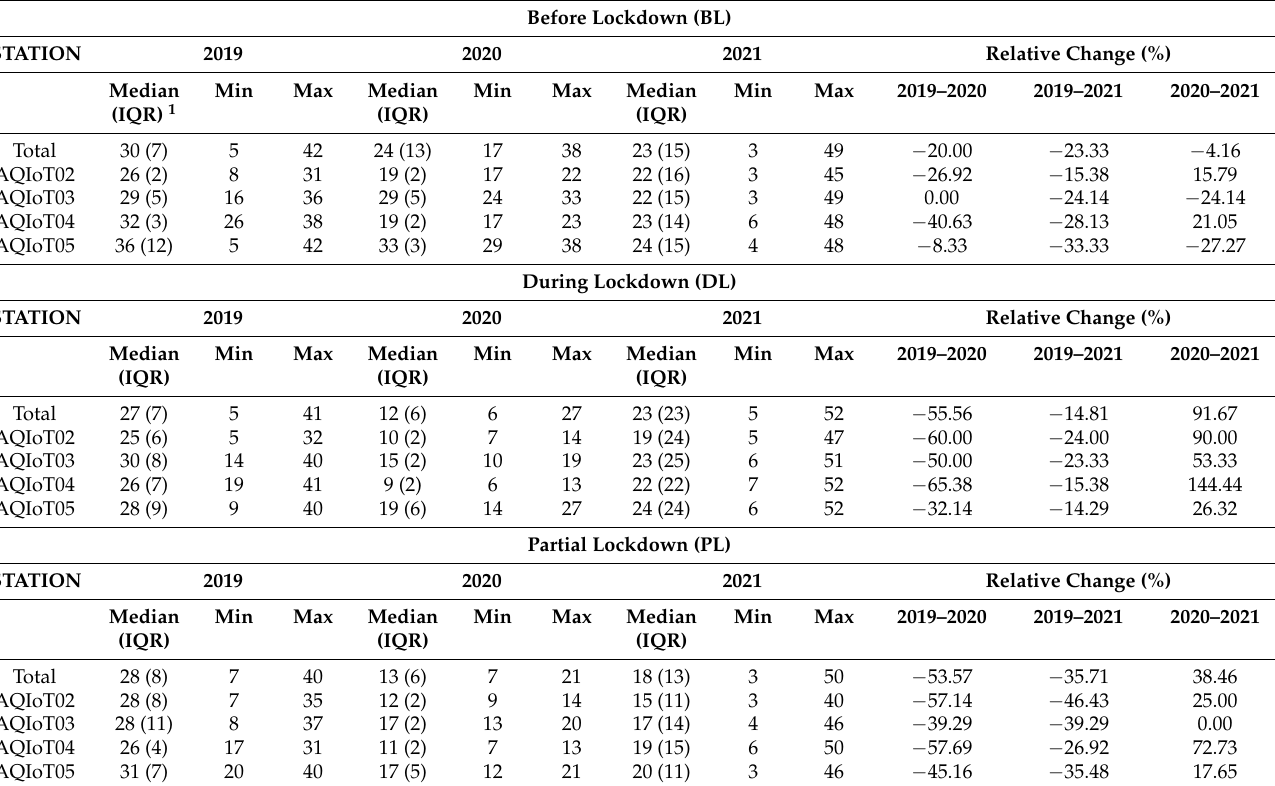
Table 1. Descriptive analysis and relative change in PM 2.5 ( µ g/m 3 ) between 16 February and 14 March (BL), 15 March and 2 May (DL), and 3 May and 6 June (PL) in Victoria City, Mexico. Before Lockdown